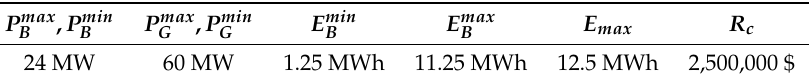
Table 1. Microgrid parameters.